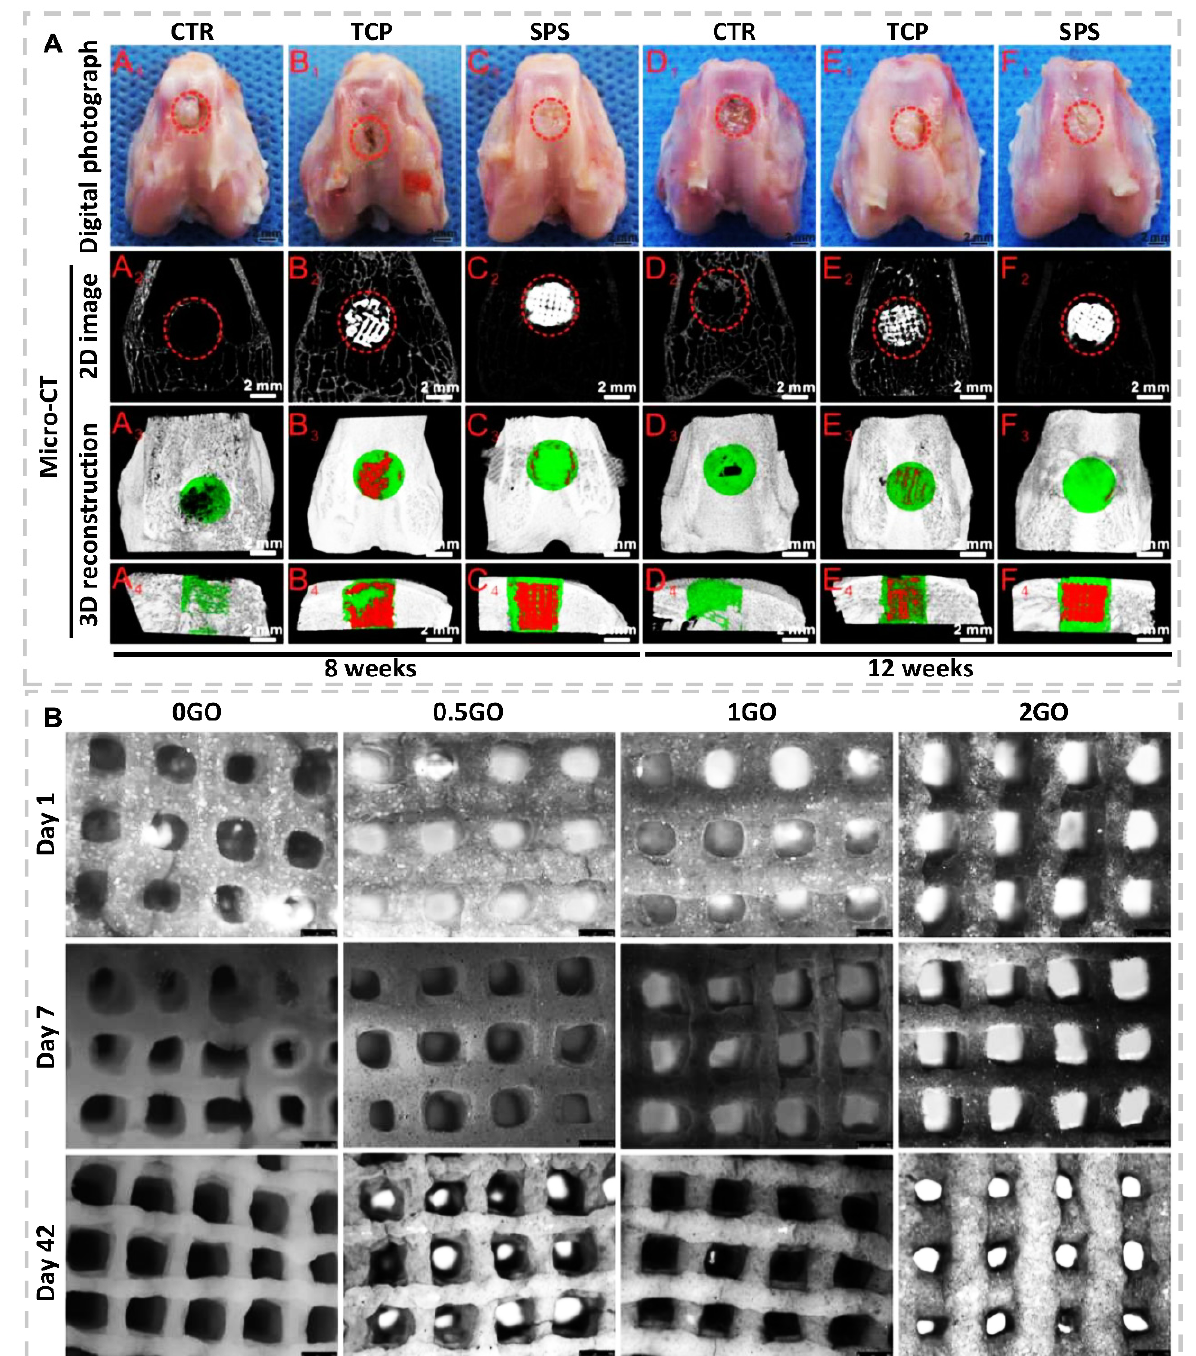
Figure 5. ( A ) Overall photographs and Micro-CT imaging analysis of defects at 8- and 12-weeks postsurgery. (A1–F1) Gross morphology of defects; (A2–F2) 2D projection images of defects; (A3–F3) and (A4–F4) illustrated transverse view and sagittal view of 3D construction images. Off-white color presents primary bone, and white color stands for scaffolds in 2D projection images. Furthermore, off-white color illustrates primary bone, green color illustrates new bone, and red color stands for scaffolds. Compared to that of CTR (blank control) and TCP groups, Micro-CT analysis of defect space exhibited a distinctly greater level of bone regeneration in SPS group (reproduced content is open access) [82]. ( B ) Light microscopy images of 3D bioprinted cell-laden GO scaffolds cultured in osteogenic media for 1, 7, and 42 days (reproduced content is open access) [85].